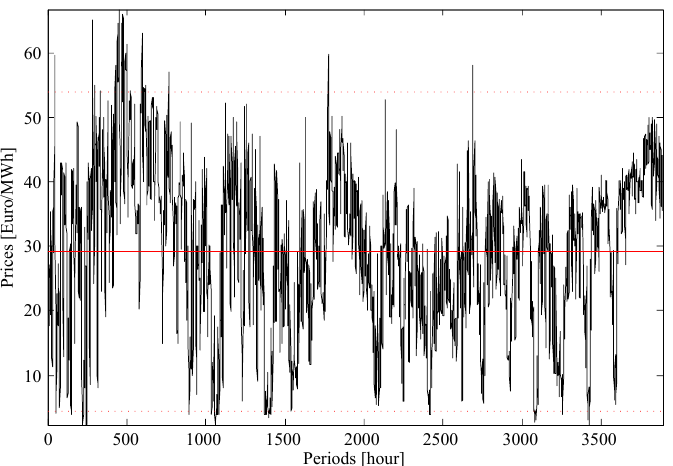
Figure 2. Prices from 1 January–10 June 2016 of the Spanish electricity